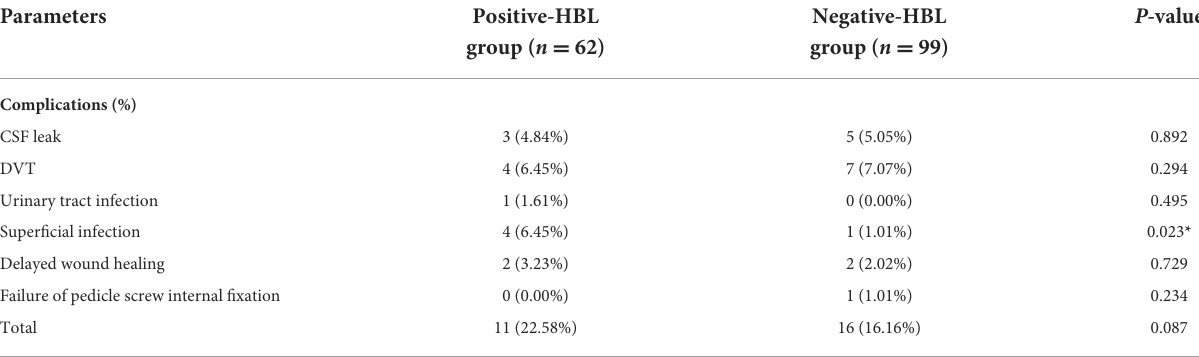
TABLE 2 Comparison of complications between the positive-HBL group and negative-HBL group.